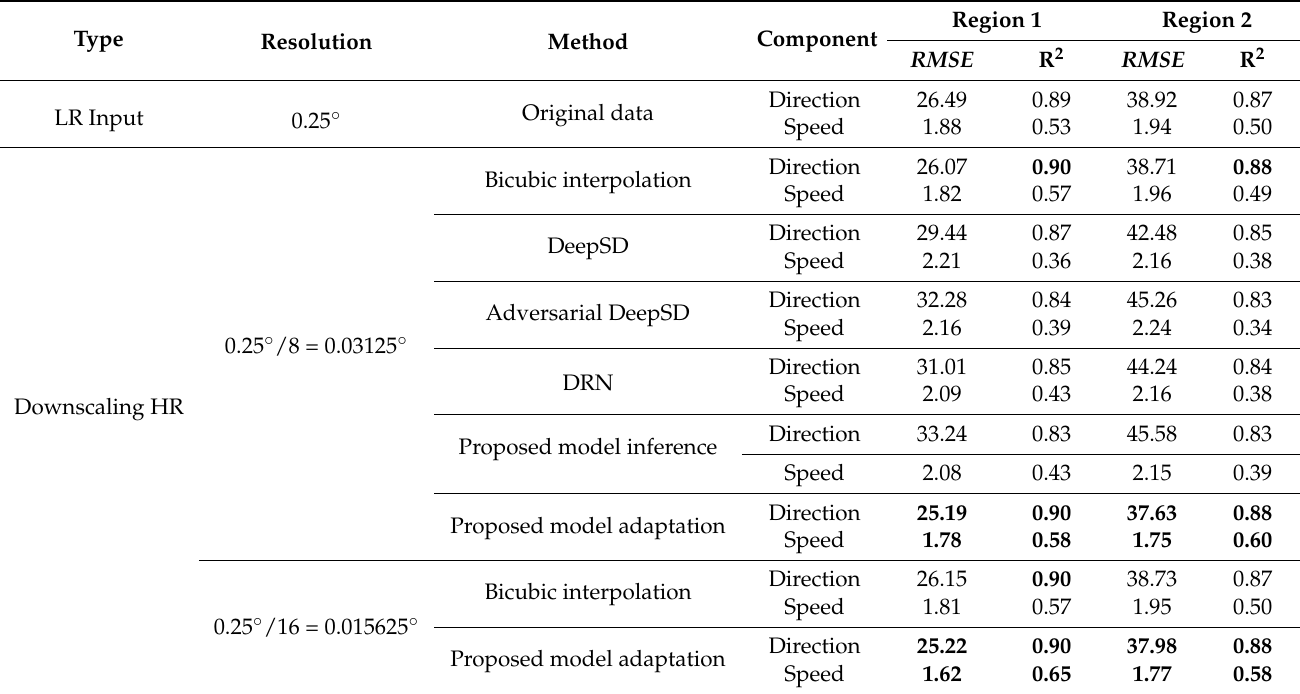
Table 5. Accuracy comparison of sea surface wind downscaling to 8 × at 0.03125 ◦ , to 16 × at 0.015625 ◦ with buoy